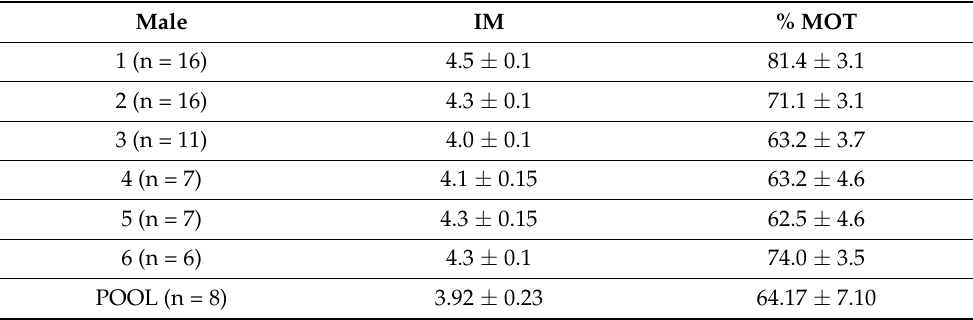
Table 4. Semen quality averages for each male in fresh semen.